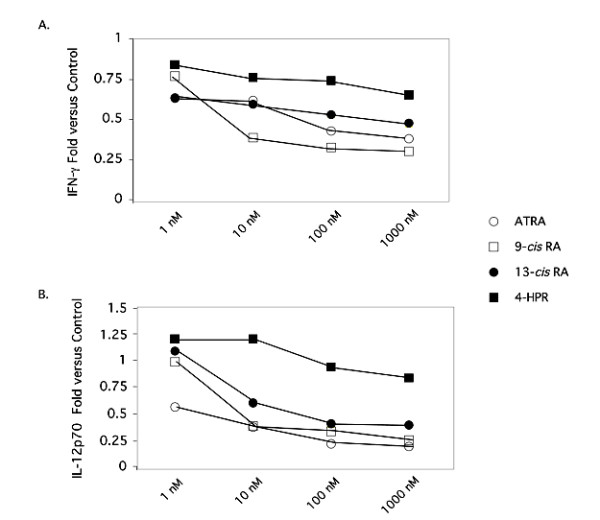
The effects of various clinically-utilized retinoid compounds on Th1-associated cytokine production by anti-CD3e-activated PBMCs. Supernatants of anti-CD3e-activated PBMCs treated with EtOH or 10-9 to 10-6 M ATRA (○), 9-cis-RA (□), 13-cis-RA (●), or 4-HPR (■) for 48 h were examined for IFN-γ or IL-12 protein levels by ELISA analysis. The values shown represent the average fold change obtained from 4 donors.